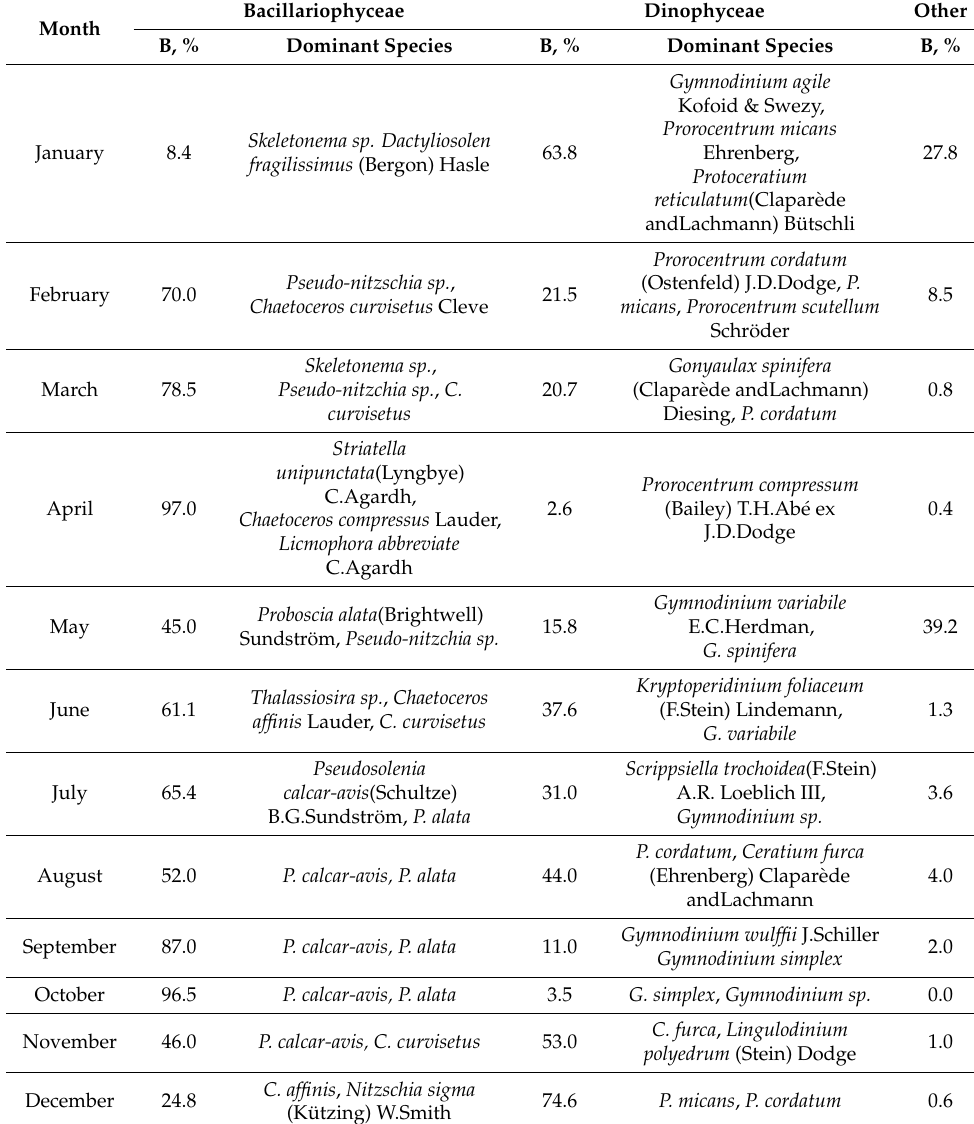
Table 1. Relative biomass (B) and dominant species of diatoms (Bacillariophyceae) and dinoflagellates (Dinophyceae) in the phytoplankton of Station 1 in